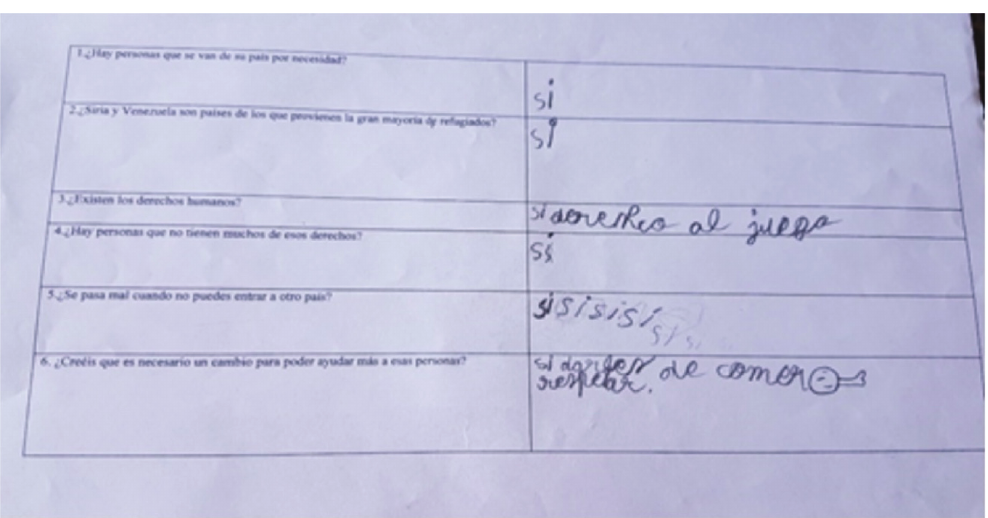
Figure 4: Evidence of the students’ learning through a self-assessment table of items completed by the learners themselves, in which the word ‘respect’ was written by a student (Photograph: Author,